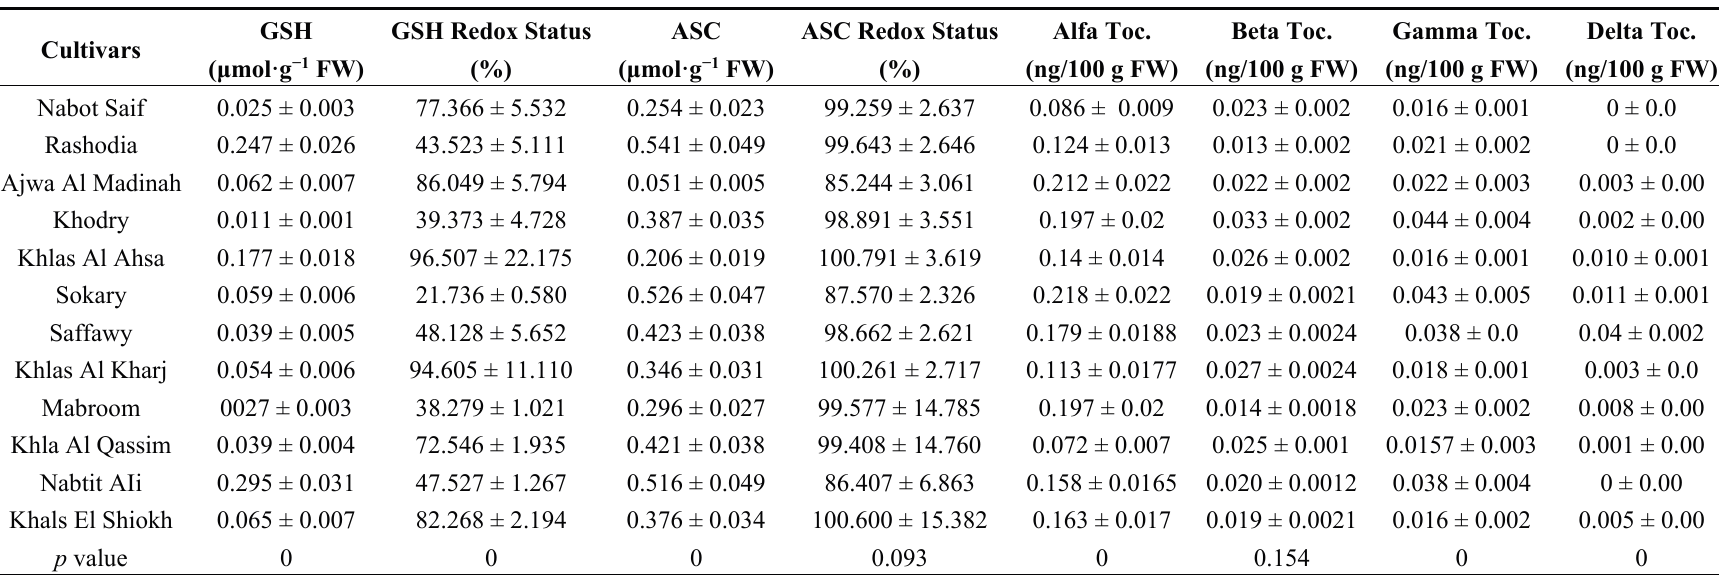
Table 1. Concentrations of glutathione (GSH), ascorbate (ASC) and tocopherols (toco), and redox status of GSH and ASC in 12 Saudi date